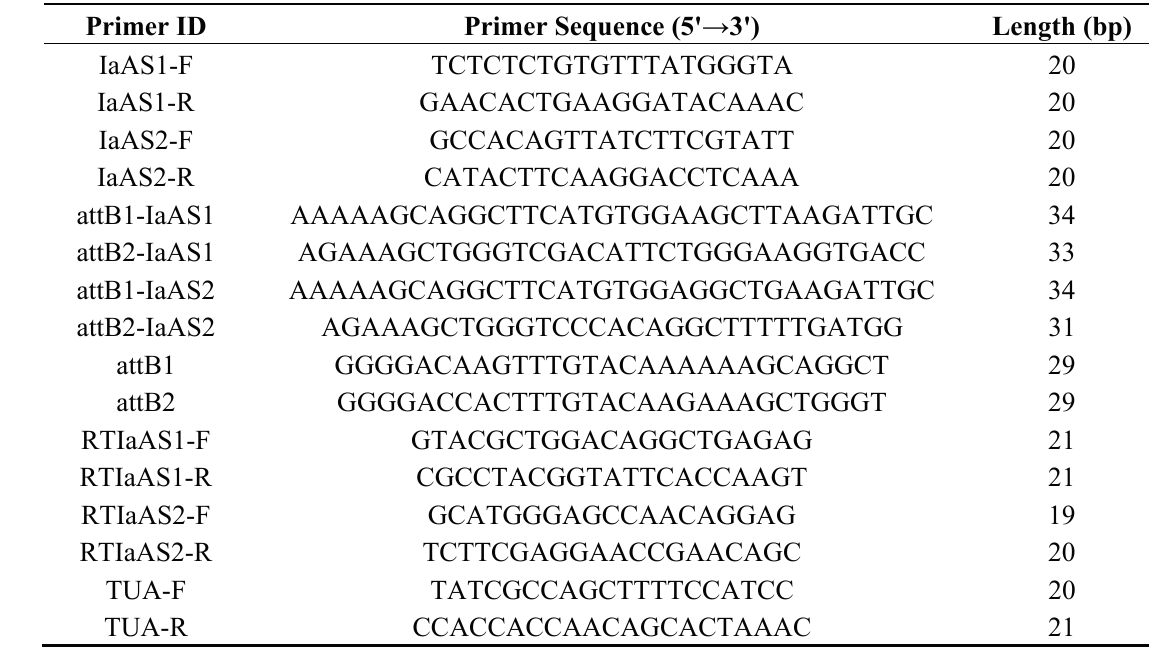
Table 2. List of primers used in this